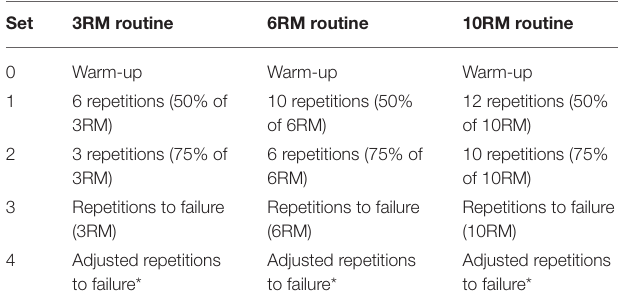
TABLE 2 | Adjusted progressive resistance exercise training